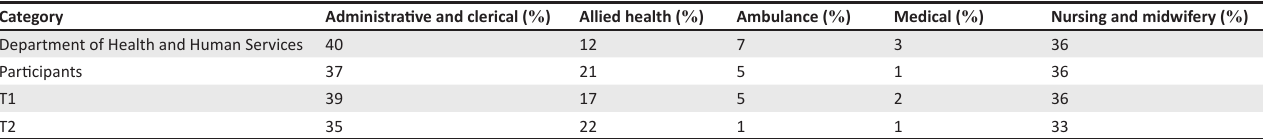
TABLE 3: Professional profiles of Department of Health and Human Services staff, participants.